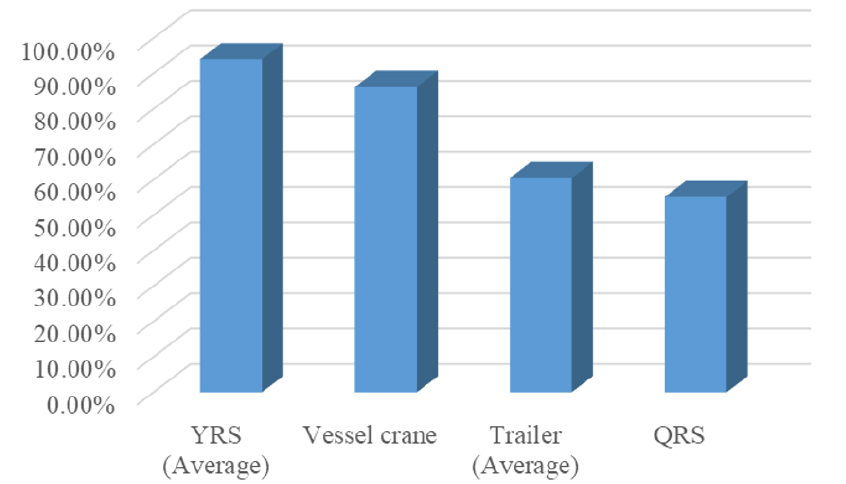
Figure 9. Equipment Utilization with 3 Trailers and 1